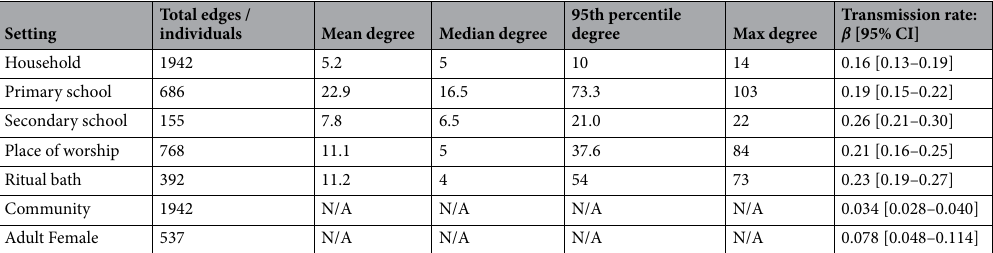
Table 1. Characteristics of the network in edges and degree for each setting. For general community transmission and transmission to adult women, the figure in the second column is the number of individuals. Final column is transmissibility estimate and 95% credible interval for each location. β has units of rate of transmission per embedding (see below) unit